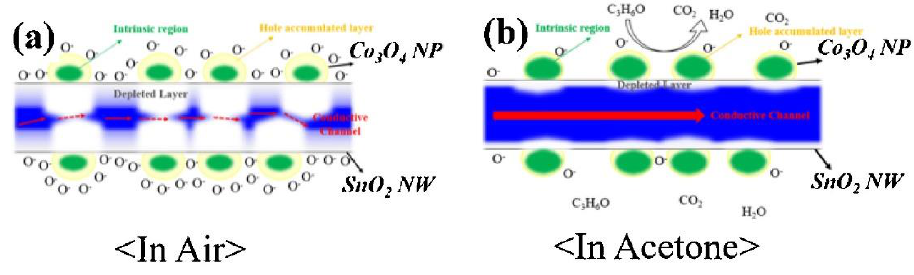
Figure 8. Schematic of acetone sensing mechanism of Co 3 O 4 -loaded SnO 2 NWs ( a ) in air and ( b ) in acetone [122]. Reprint permission was obtained from Elsevier.